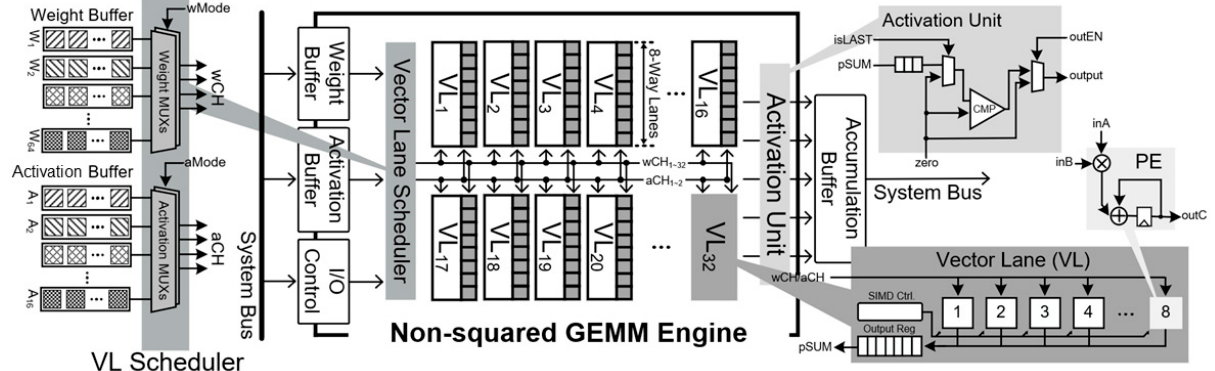
Figure 6. Hardware block diagram of CONNA architecture.